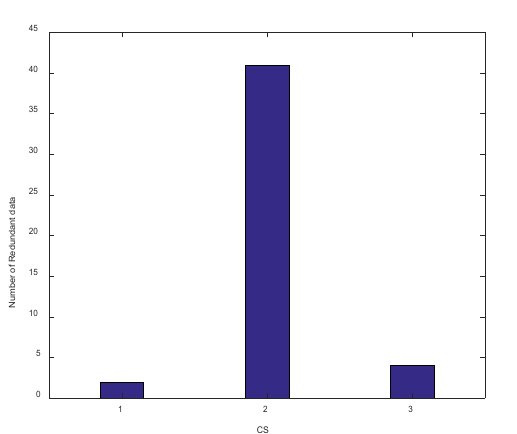
Fig .5 . Total time needed for all